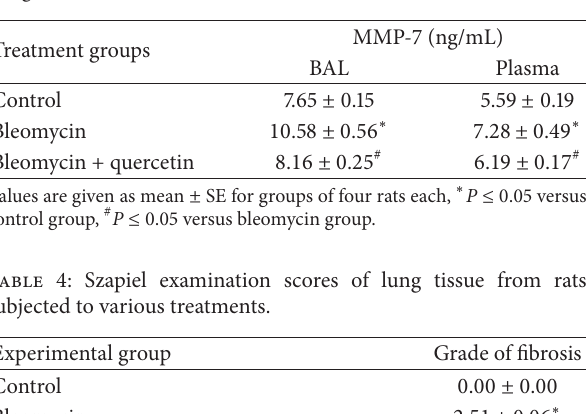
Table 3: Level of MMP-7 in blood plasma and bronchoalveolar lavage fluid.